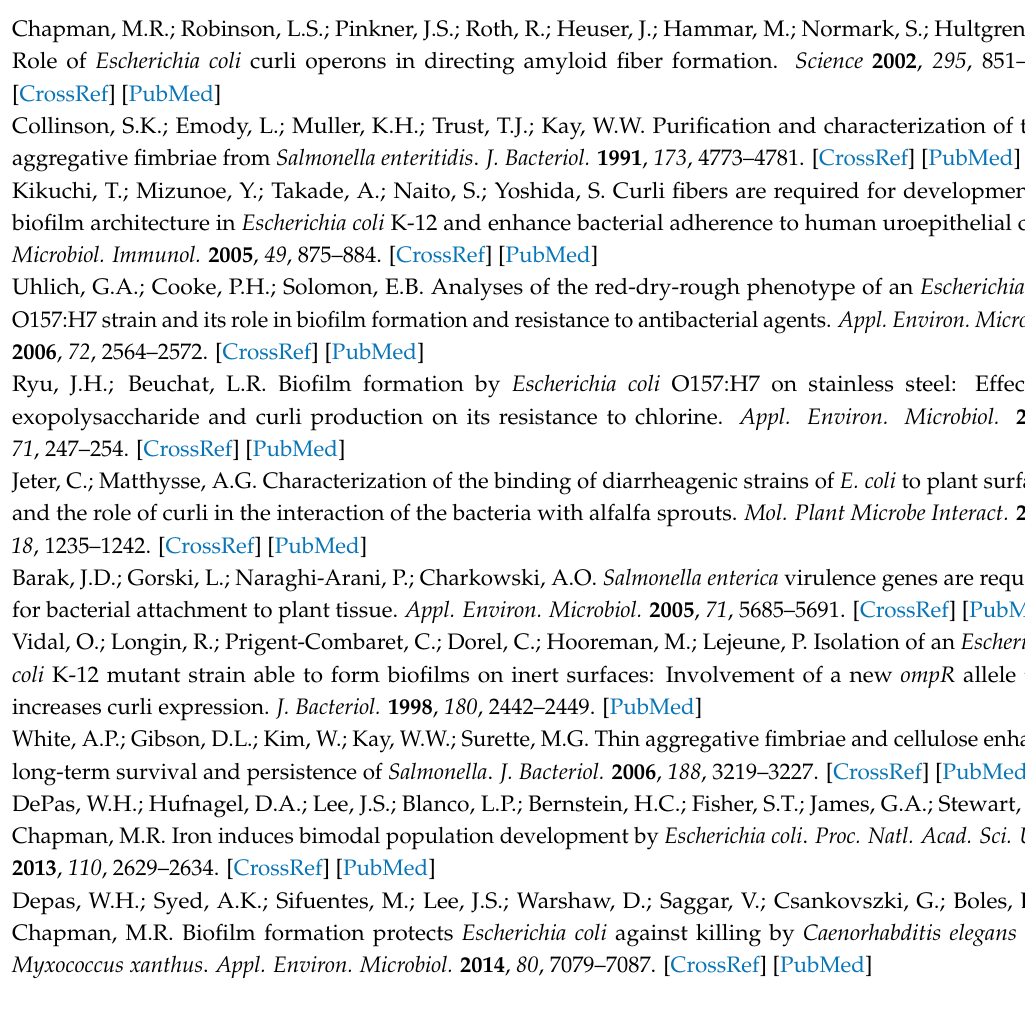
Figure S1: Congo Red and hydrophobicity of different LPS mutant E. coli strains, Figure S2: Differences in Congo Red phenotypes of Keio collection strains on YESCA and CFA plates and CFA plates without Coommassie Brilliant Blue counterstain, Figure S3: qRT-PCR of inner core LPS and nhaA mutants, Figure S4: Effects of σ E induction on curli production, Figure S5: The intergenic region between csgD and csgB has many transcriptional binding sites, Figure S6: Low ppGpp strains and dksA mutants produce less curli, Table S1: Congo red phenotypes and Western blot data from Keio strains with altered curli production, Table S2: Phenotypes of suppressor strains with more than one CR phenotype and the primers used, Table S3: Cellular localization of identified gene products, Table S4: Genes required for or known to affect curli production, Table S5: CsgD regulon excluding c sgBA C and cs gDEF G, Table S6: Intergenic regions in E. coli and the number of transcriptional binding sites in divergent intergenic regions, Table S7: Venn diagram gene List, Table S8: Congo red phenotypes of Keio strains on YESCA and CFA plates or CFA plates without Coommassie Brilliant Blue, Table S9: CsgD protein and transcript levels relative to WT, Table S10: Strains, plasmids, and primers